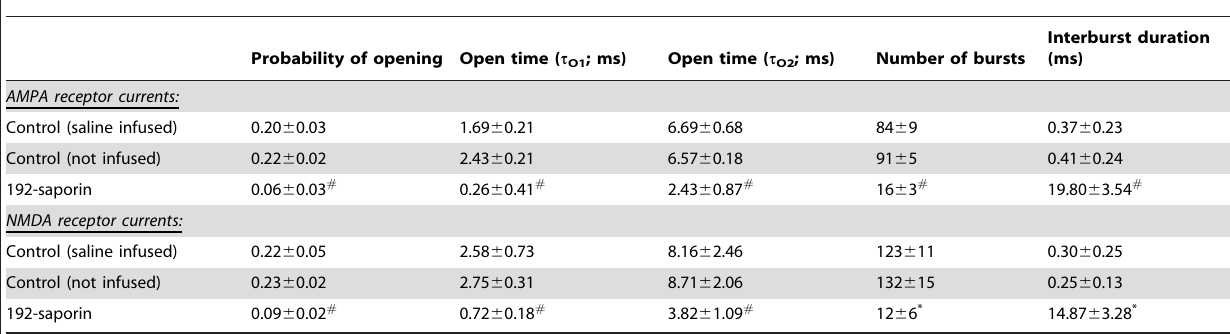
Table 2. Burst analysis of AMPA and NMDA receptor single channel currents in